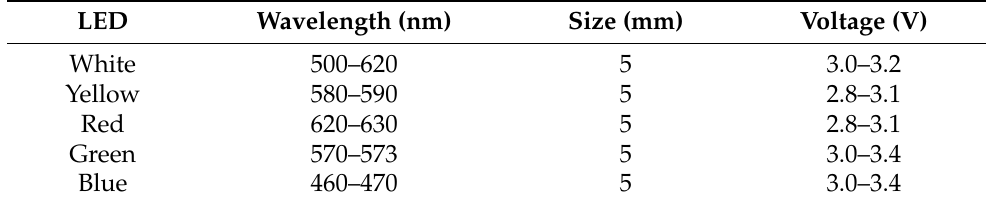
Table 2. LED set